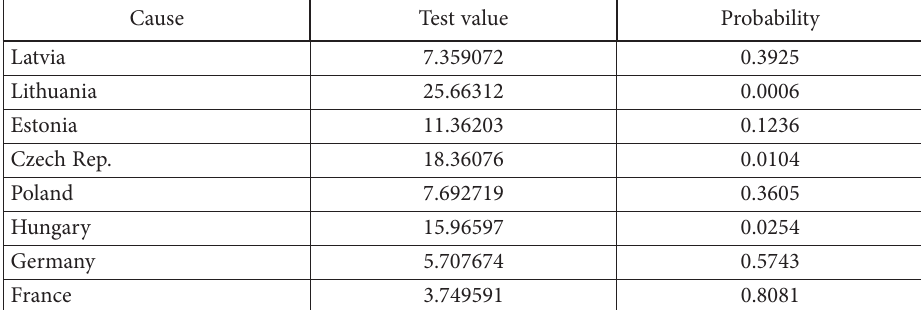
Table 3. Granger causality test results for VAR model (source: Results obtained by the authors) Cause Test value Probability